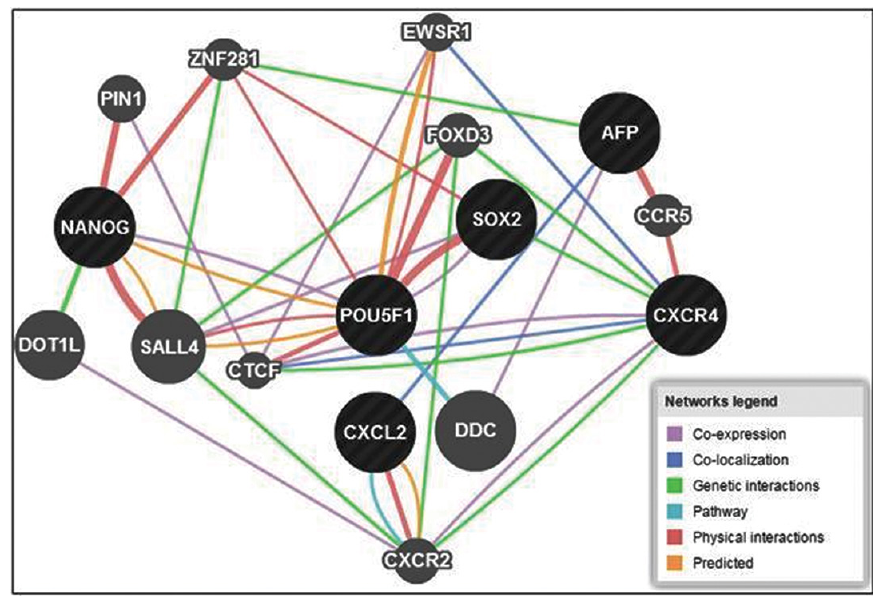
Figure 4. Interactive functional association network of the gene set. The network nodes are proteins. Predicted functional links between the proteins are indicated by edges in color coded lines. GeneMANIA was used